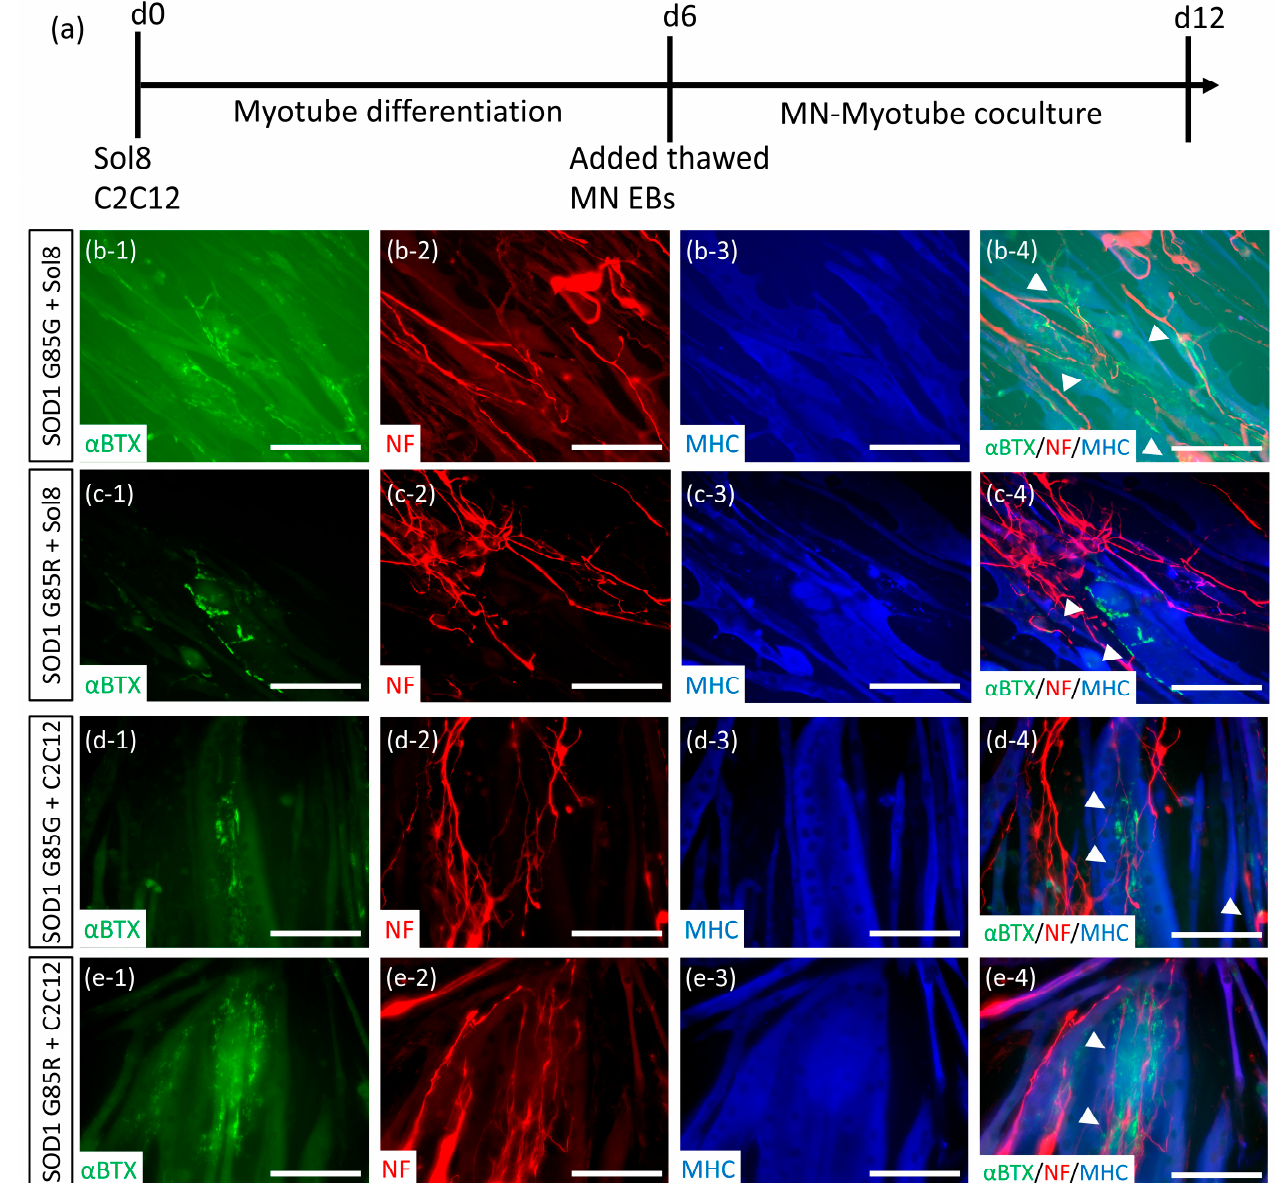
Figure 5. Thawed MNs formed a neuromuscular junction (NMJ)-like structure with mice myoblast cell lines. ( a ) The MN-myoblast coculture procedure. ( b – e ) Neuronal (NF), myotube (myosin heavy chain, MHC), and NMJ-specific marker (acetylcholine receptor, recognized with α -BTX) expression and colocalization of the SOD1 G85G MN-sol8 ( b ), SOD1 G85R MN-sol8 ( c ), SOD1 G85G MN-C2C12 ( d ), and SOD1 G85R MN-C2C12 coculture ( e ). Colocalizations of NF, MHC, and α -BTX are indicated by arrowheads. Number 1 − 3 presenting the separated images and number 4 presenting merged images in (b − e). Scale bar, 100 μ m.